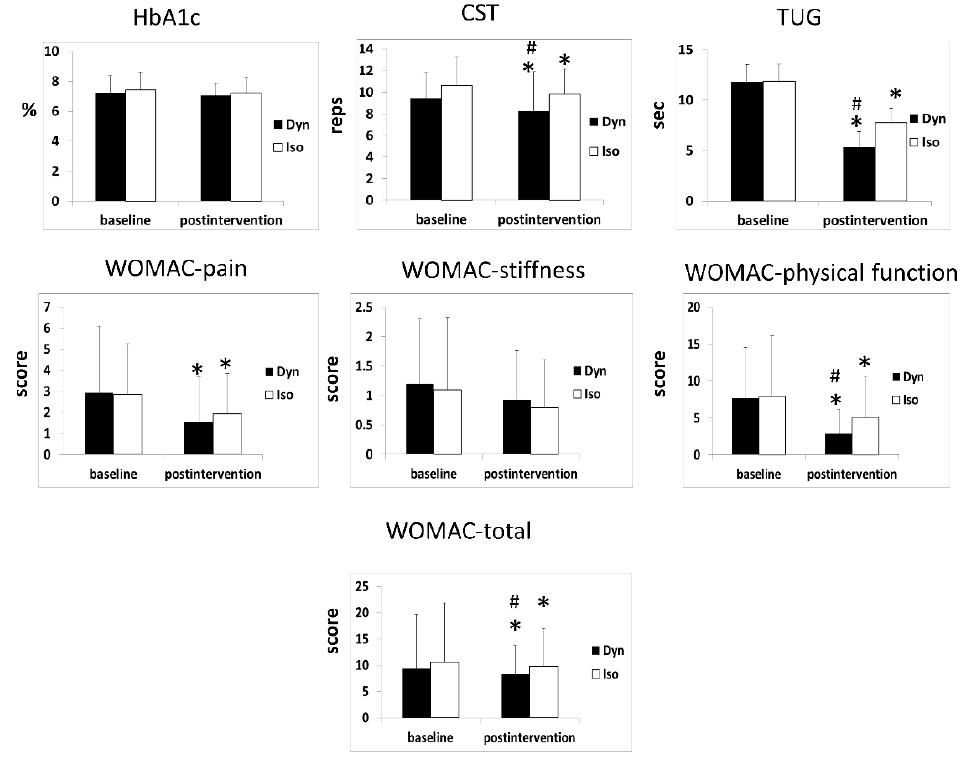
Figure 3. Improvements in HbA1C, CST, TUG, and WOMAC after the 12-week intervention between groups. Dyn = dynamic group, Iso = isometric group. * vs baseline ( p < 0.05) # vs Iso ( p <